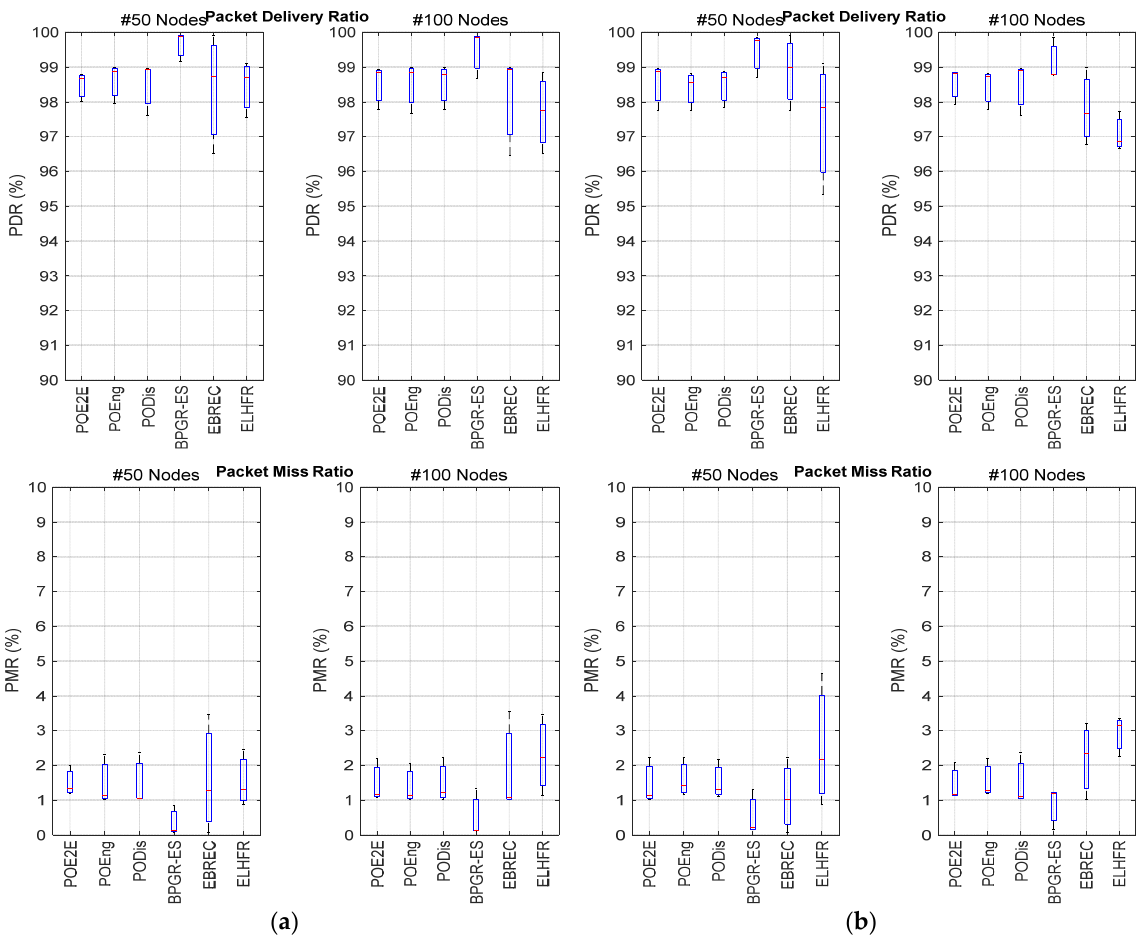
Figure 4. PDR and PMR boxplots for different topologies: ( a ) PDR and PMR results of the 100 × 100 m 2 network area of 50 and 100 nodes; ( b ) PDR and PMR results of the 200 × 200 m 2 network area of 50 and 100